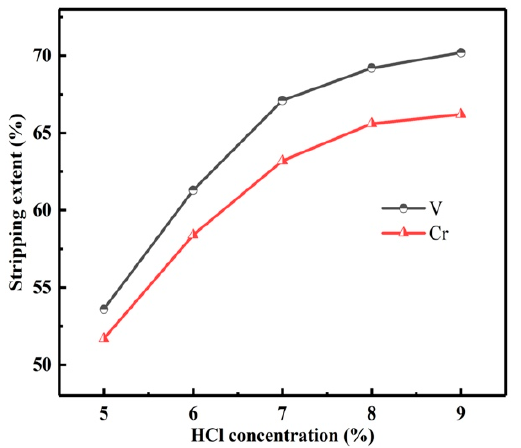
Figure 16. Influence of HCl concentration on stripping extents of vanadium and chromium.